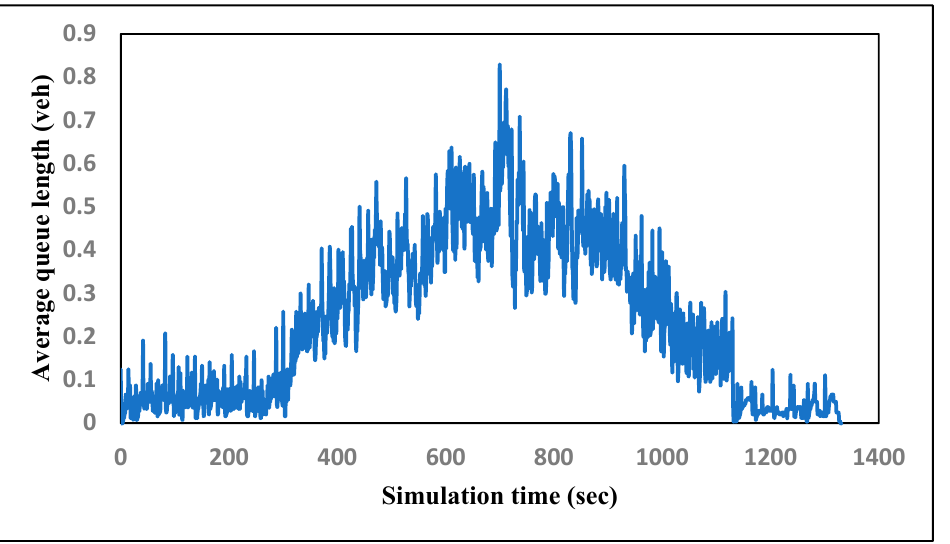
Figure 7. MA2C training curve for synthetic traffic grid.